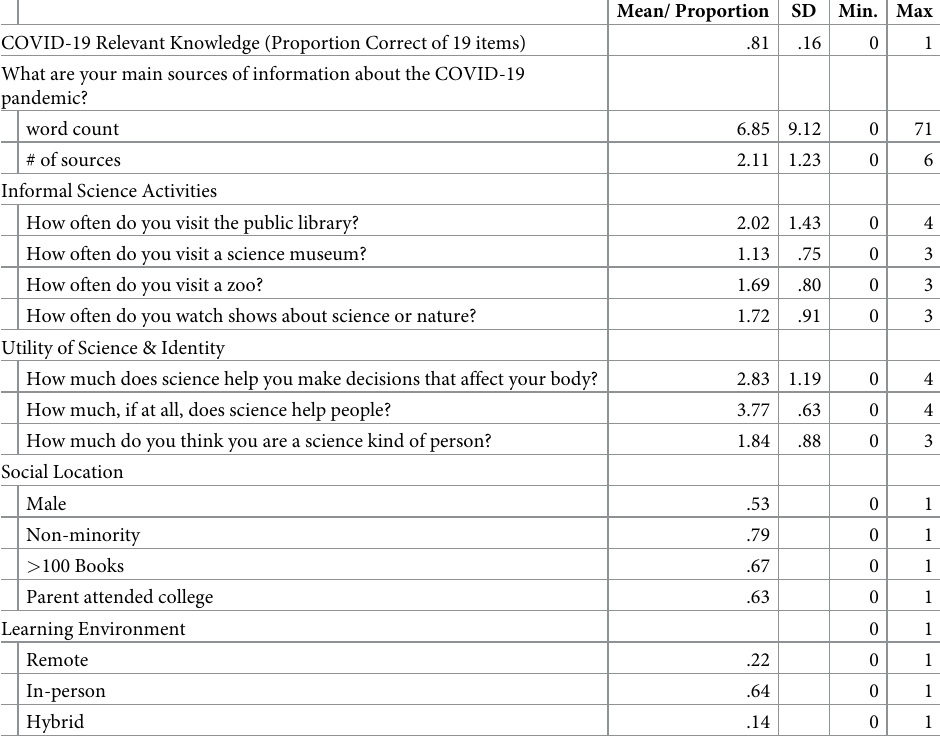
Table 2. Descriptive statistics for sample variables from youth (n = 264).